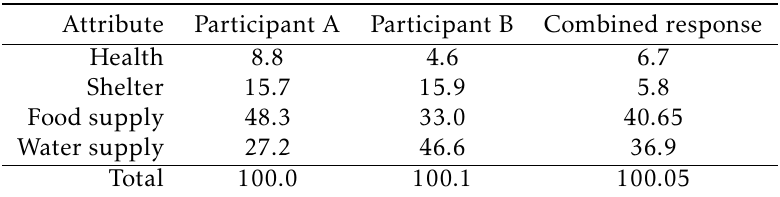
Table 1 – The relative weights (%) given to each of the four main attributes for Participants A (RB) and B (FR) and the averaged response of the two participants.